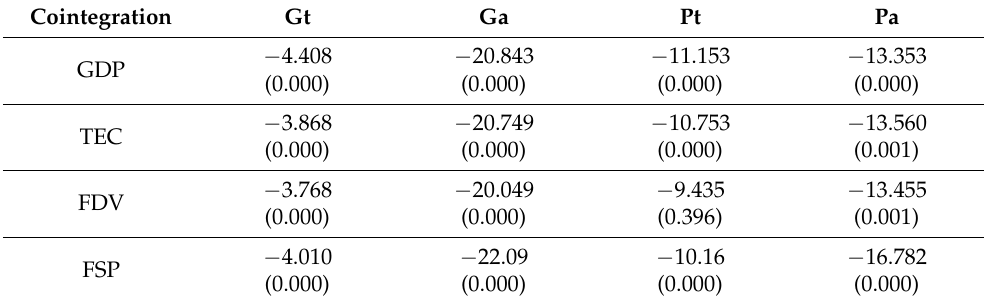
Table 5. Westerlund cointegration